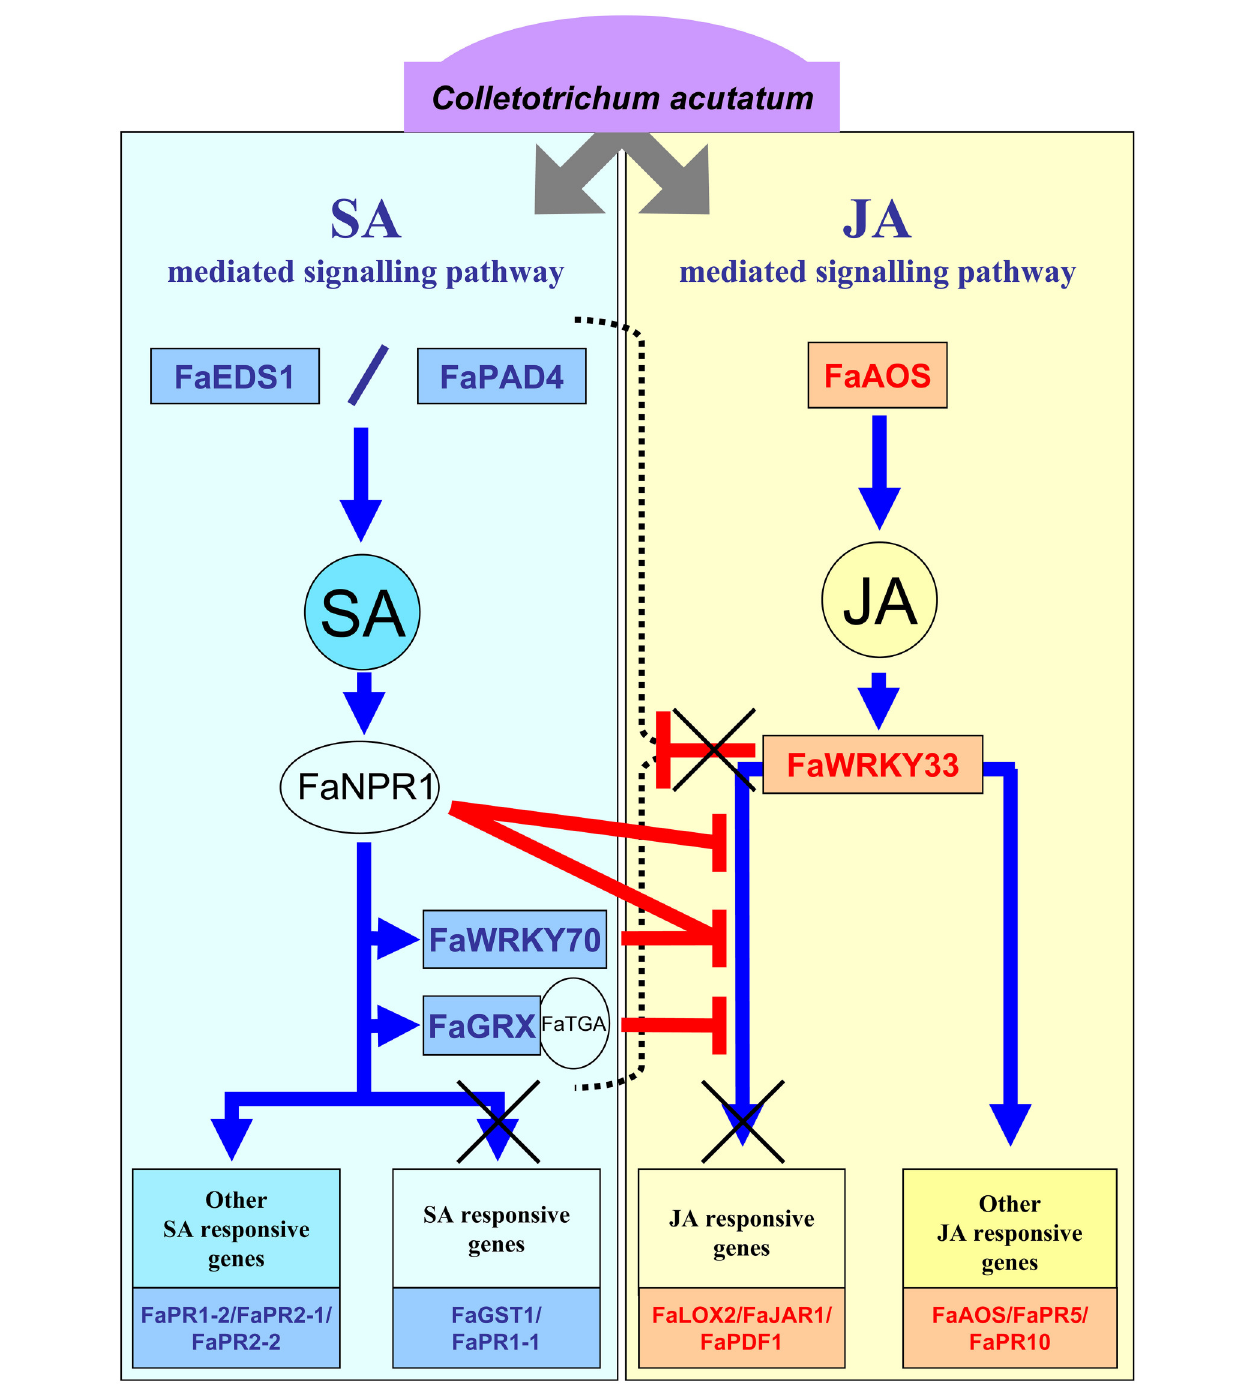
FIGURE 8 | Hypothetical model of SA- and JA-dependent defense pathways activated in strawberry in response to C. acutatum . This model is based on the canonical pathways described in model plant. Upon interaction with C. acutatum , the strawberry plant activates upstream components of SA and JA defense pathways. Thus, synthesis of these signal molecules increases and main downstream key components for SA (FaNPR1, FaWRKY70, FaGRX) and JA (FaWRKY33) are activated. Unlike Arabidopsis WRKY33, FaWRKY33 does not act as a negative regulator of the entire SA-dependent defense signaling pathway, either by a direct or an indirect effect of fungal activity, but only for some components (FaGST1, FaPR1.1). That allows FaGRX, together with FaNPR1 and FaWRKY70, to act as negative regulators of JA responsive genes similarly to their Arabidopsis orthologs. As a result, important JA-responsive defense marker genes, such as FaLOX2, FaJAR1, and FaPDF1, are not induced. These impaired mechanisms might provide some advantage for fungal spreading.